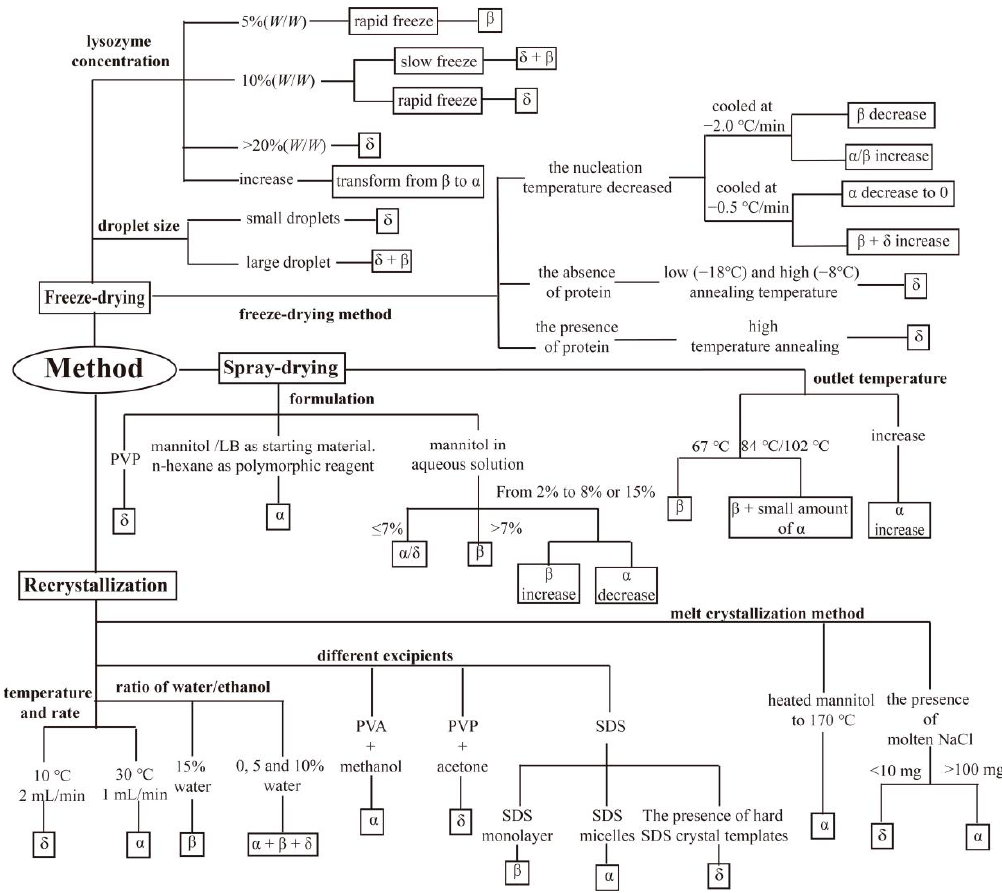
Figure 11. The polymorphic control strategies of different mannitol preparation methods.